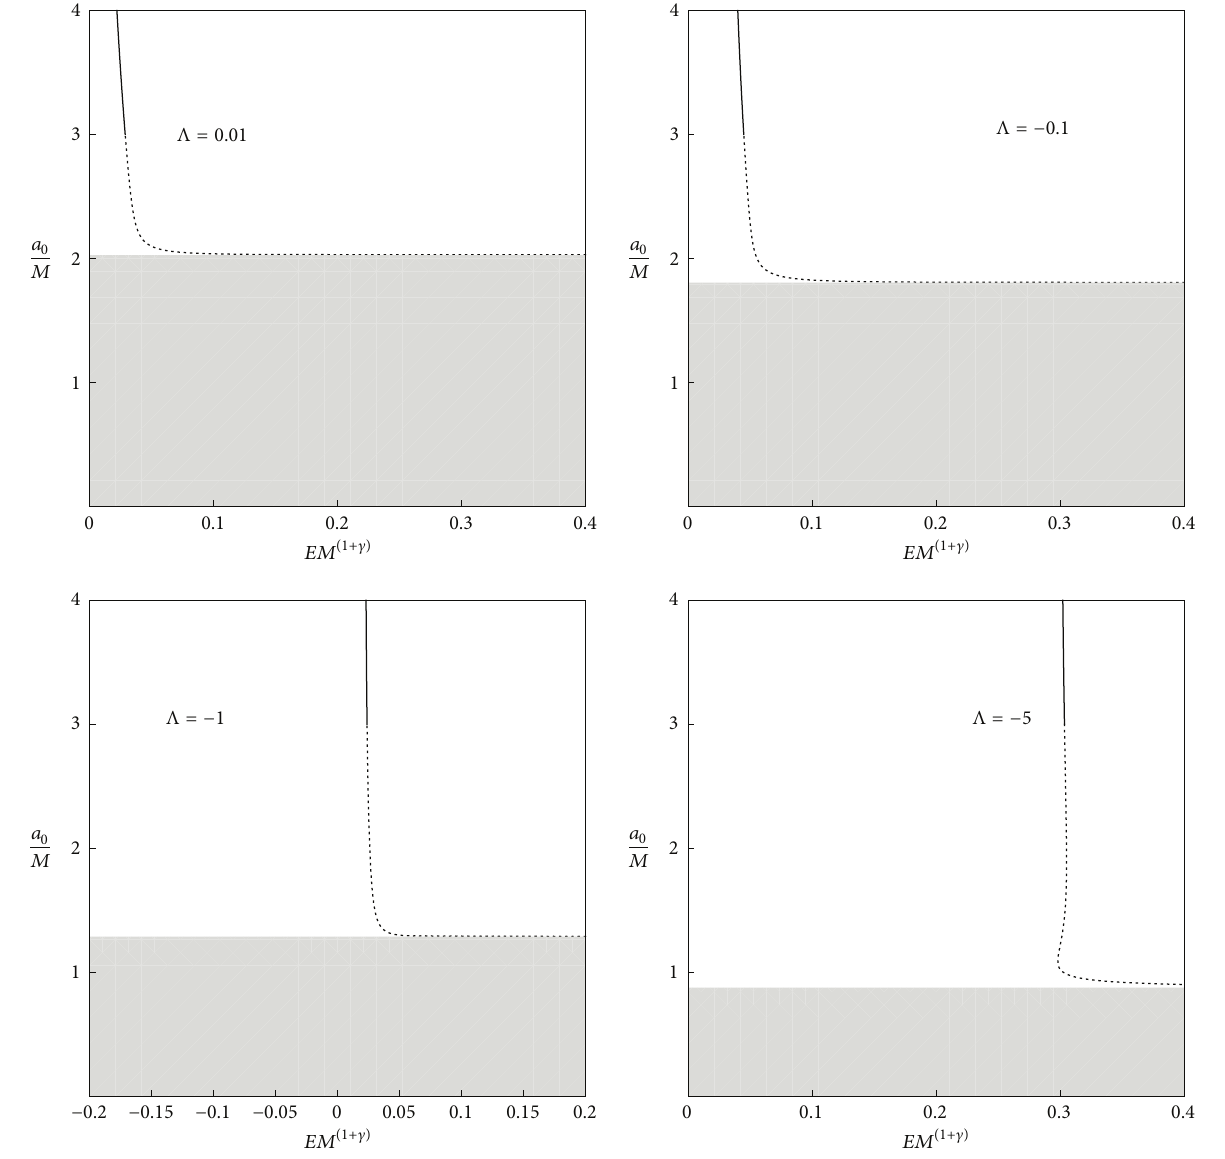
Figure 7: Plots for MCCG with 𝛾 = 0.2 , 𝑀 = 1 , 𝐴 = 2 , and 𝑤 = −10 .